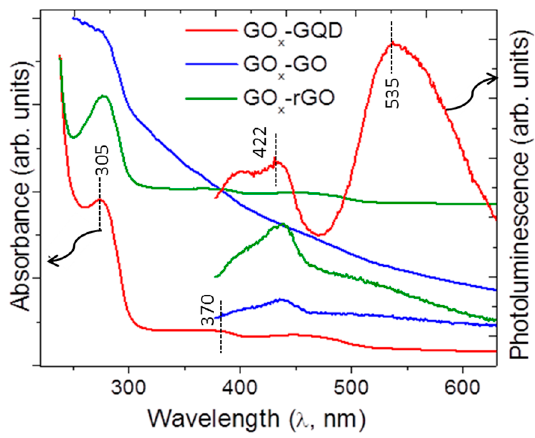
Figure 2. UV-Vis absorption and photoluminescence spectra of enzymatic GO x protein in the presence of water-dispersed GQD, GO, and rGO, depicting characteristic peaks.